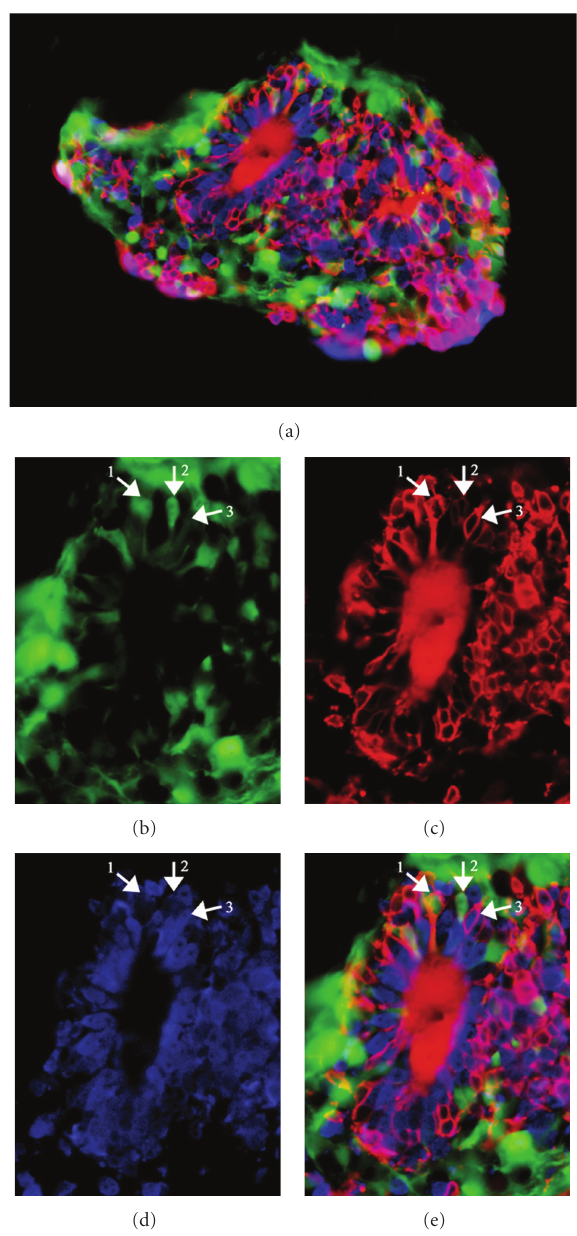
Figure 5: Photoreceptor marker expression within a rosette of donor origin. Recipient was 6 weeks of age at time of transplantation and experiment terminated 5 weeks later. (a) Immunohistochemical labeling of the same RPC graft was shown in previous figure. Endogenous GFP fluorescence (green) was present in many cells of the graft, but less so within the rosettes. The largest, most well formed of the rosettes was selected for more detailed evaluation of individual marker expression patterns. (b) GFP labeling was most notable around the periphery of the rosette; however, GFP+ profiles were also integrated into this structure, with small peripheral soma and straight process oriented towards the core of the rosette (arrow 1). An adjacent region (arrow 2) shows a similar cell with a less clearly defined process. A third cell (arrow 3), does not express GFP. (c) Rhodopsin labeling (red) is strongest in the central core of the rosette. In addition, multiple profiles exhibiting rod photoreceptor morphology can be seen to contribute to the rim of the rosette, and these have cell bodies located around the periphery and processes directed inward where they merge with the central core. The arrows point to the same profiles as before, in this case showing strong rhodopsin labeling (arrow 1), no rhodopsin (arrow 2), and moderate rhodopsin (arrow 3). (d) Recoverin (blue) labeling was dense in areas populated by rhodopsin-positive cells and revealed a dense ring of recoverin-positive cells central to the rhodopsin-positive somata, although this labeling did not extend into the core of the rosette despite some marginal overlap at the interface. (e) The merged image reveals that much of the rhodopsin colabels recoverin-positive cells, whereas many recoverin-positive cells do not appear to colabel with rhodopsin. The core is exclusively positive for rhodopsin, as previously